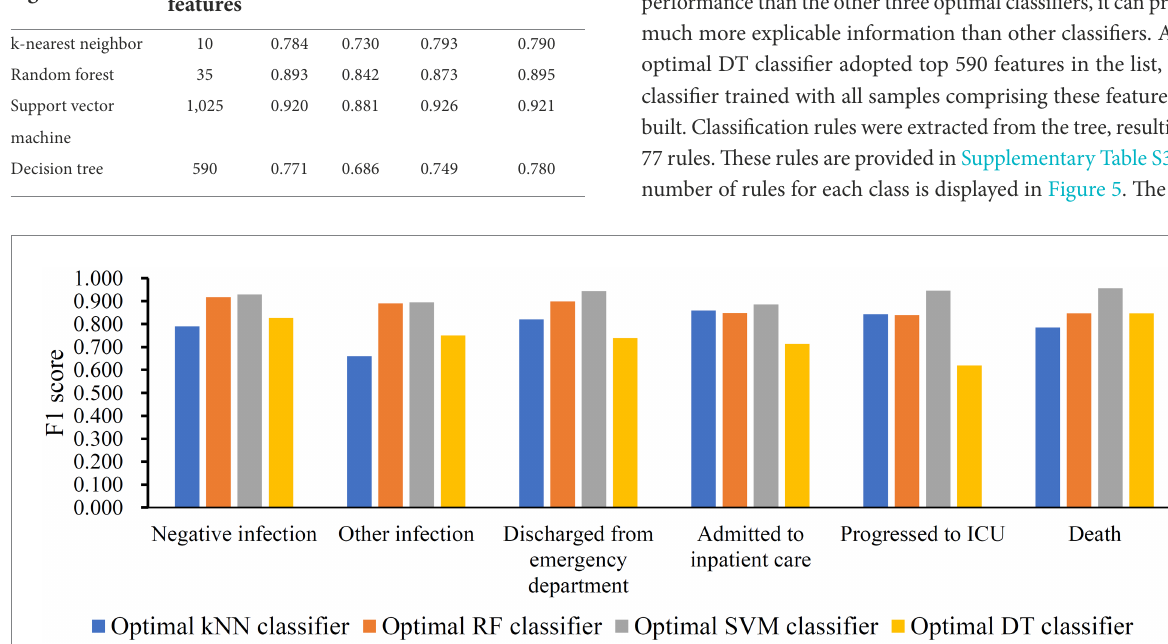
FIGURE 4 Performance of four optimal classifiers on six classes. The optimal SVM classifier produced best performance on all classes.